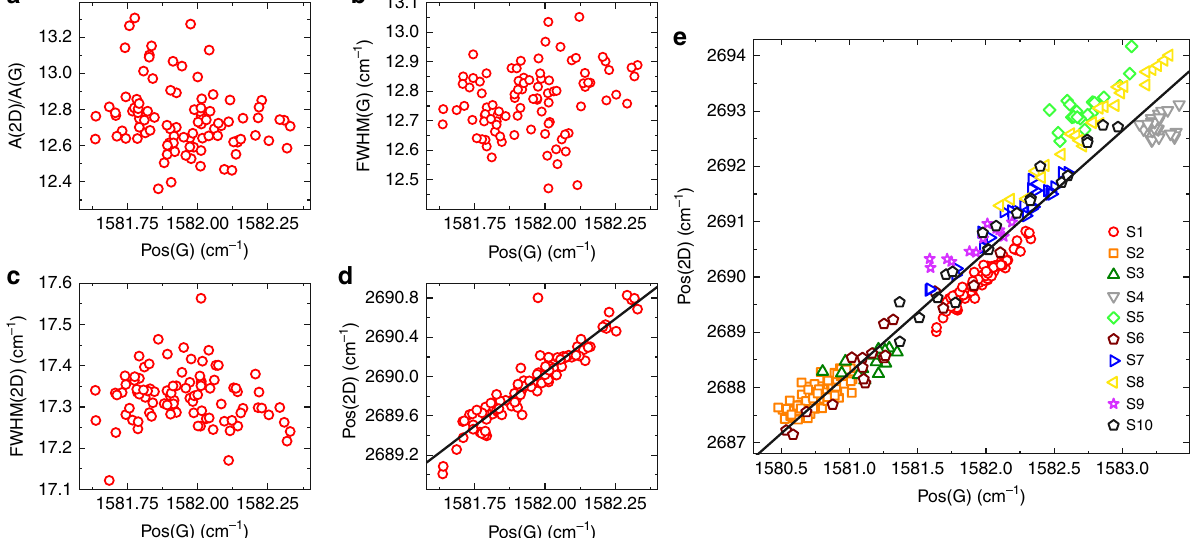
Fig. 6 Raman fi tting parameters of hBN/SLG/hBN Hall bars. a – d Pos(2D), A(2D)/A(G), FWHM(2D), FWHM(G) as a function of Pos(G) measured across a 20 μ m × 20 μ m region of a Hall bar (optical image shown in the inset of Fig. 7). e Pos(2D) vs. Pos(G) for 10 samples (S1-S10). S1 corresponds to the measurements in a – d . Solid black lines represent linear fi ts to the